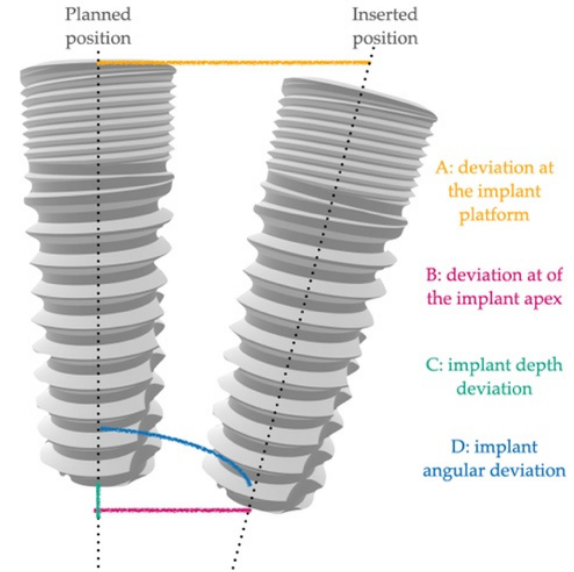
Figure 2. Graphical representation of the measurements. Differences between planned and inserted position were registered as: A—deviation at the implant platform, B—deviation of the implant apex, C—implant depth deviation, and D—implant angular deviation.